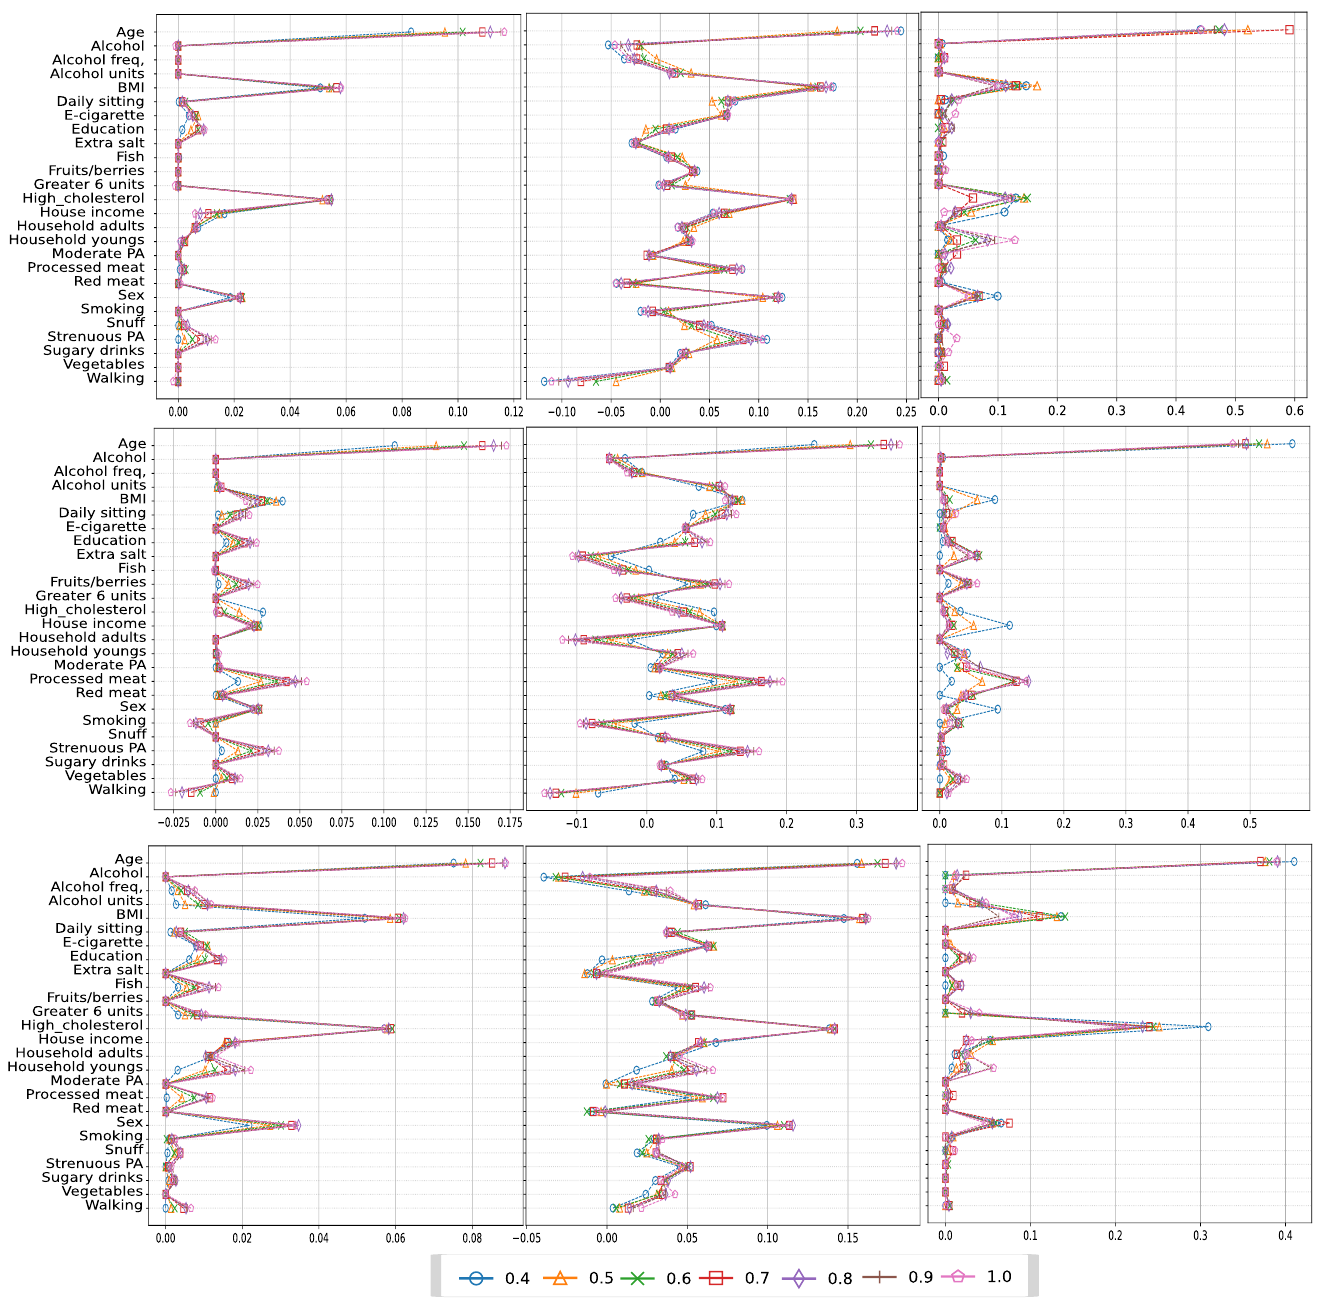
Figure 7. Coefficient values for different IR when using LASSO ( left panels ), SVM ( middle panels ), and DT ( right panels ) and the oversampling methods with all features: SMOTEN ( first row ); TVAE ( second row ); and CTGAN ( third row